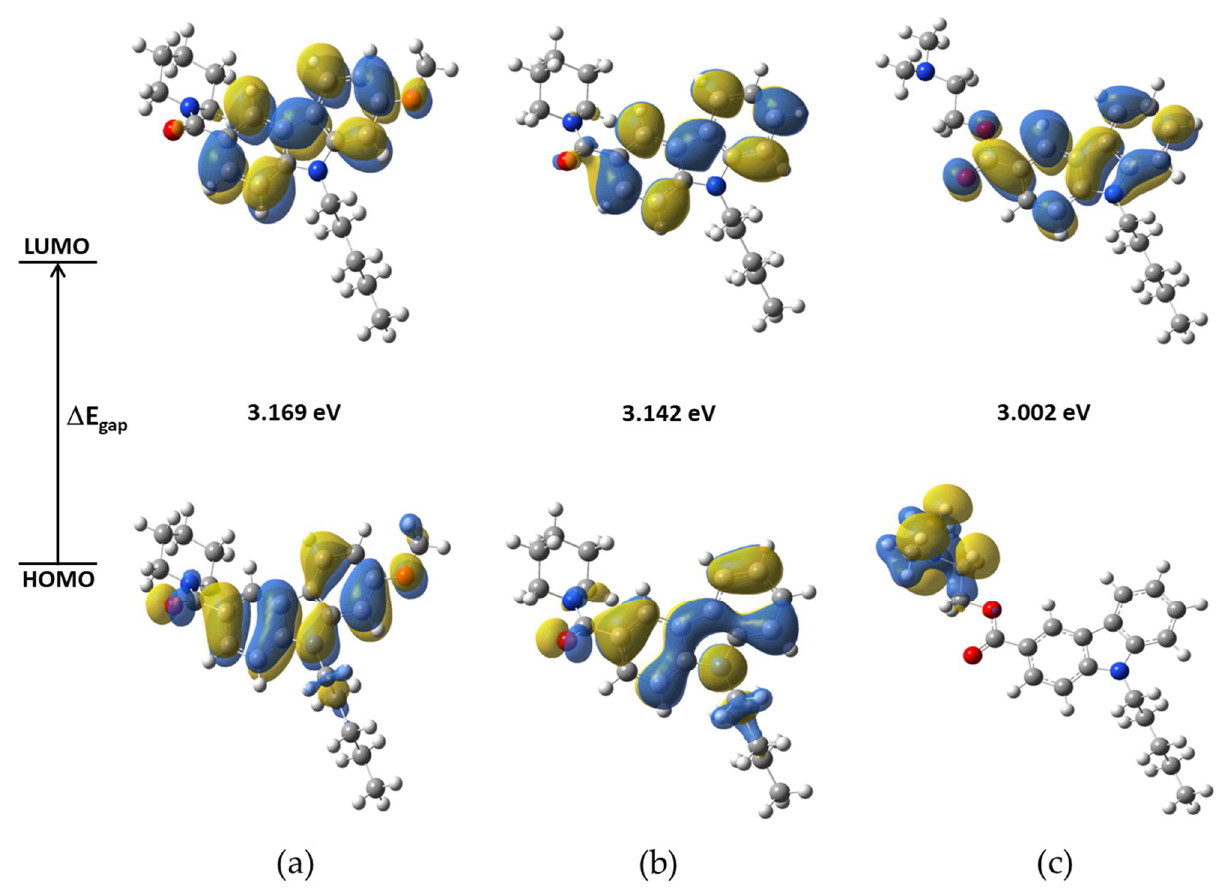
Figure 4. Frontier molecular orbitals (HOMO and LUMO) and ∆ E gap values. In: ( a ) NMP-4, ( b ) NMP-7, and ( c ) NMP-181 compounds at BP86/cc-pVTZ level of theory in chloroform.